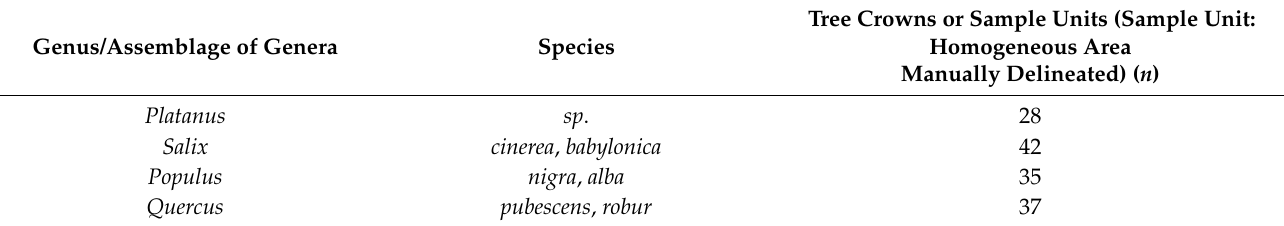
Table 1. Predominant genera and species